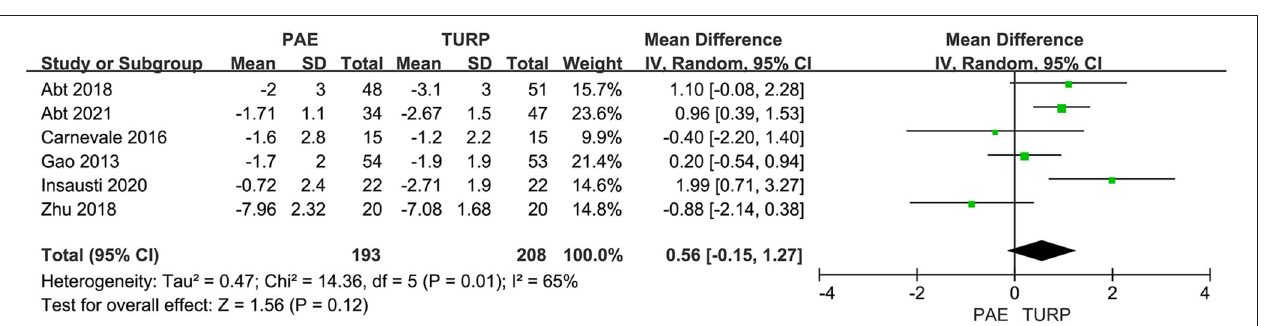
FIGURE 7 | Forest plot for PSA. PSA, prostate-specific